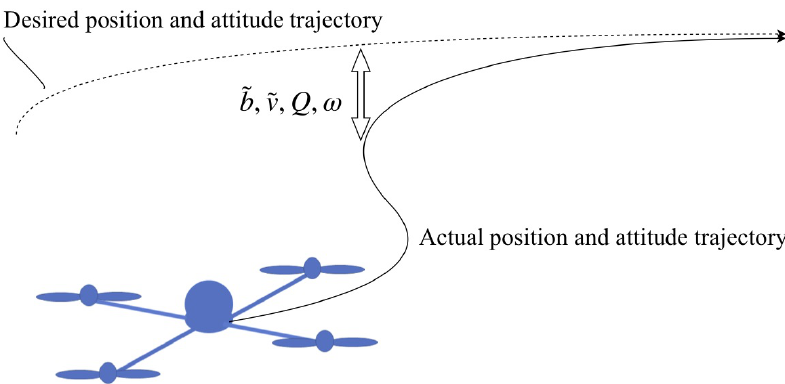
Figure 1. Tracking